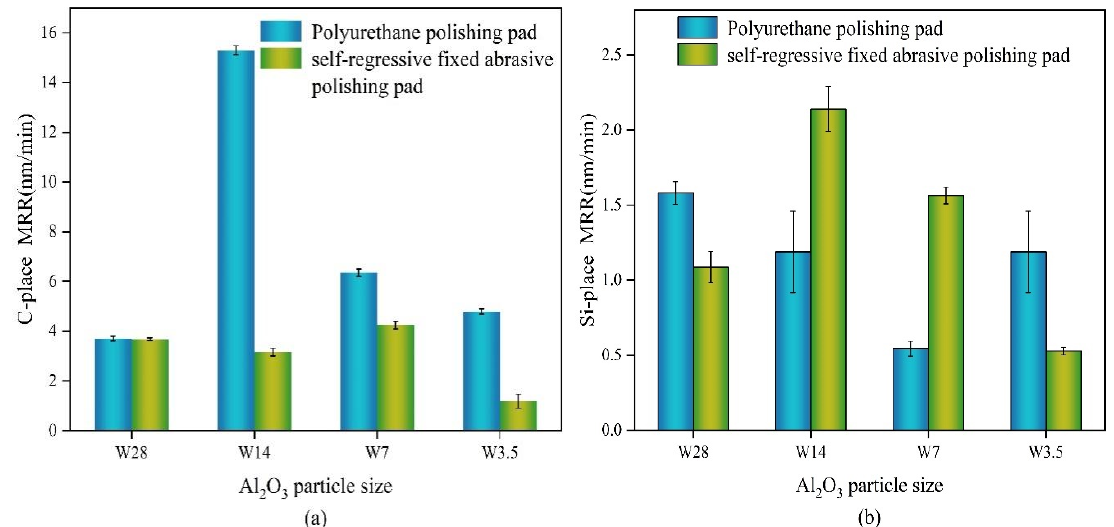
Figure 16. The polishing effect of the abrasive particles’ size on both sides of the C and Si planes. ( a ) Removal rate of the C-plane material. ( b ) Removal rate of the Si-plane material.